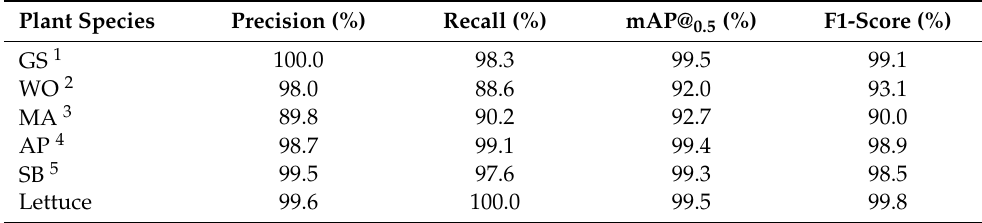
Table 2. Classification results of different plants based on SE-YOLOv5x model on